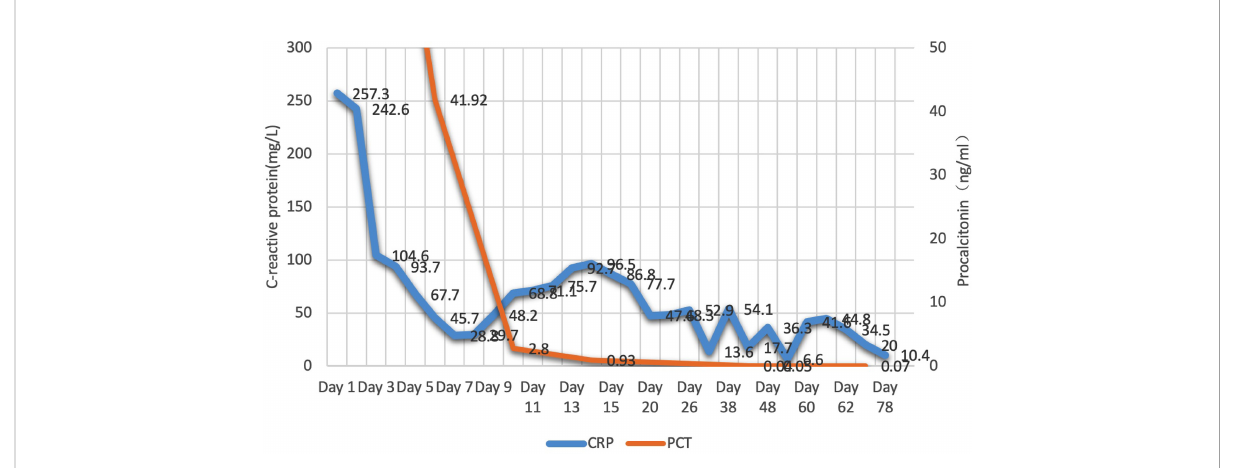
FIGURE 4 Change in C-reactive protein (CRP) and procalcitonin(PCT) during